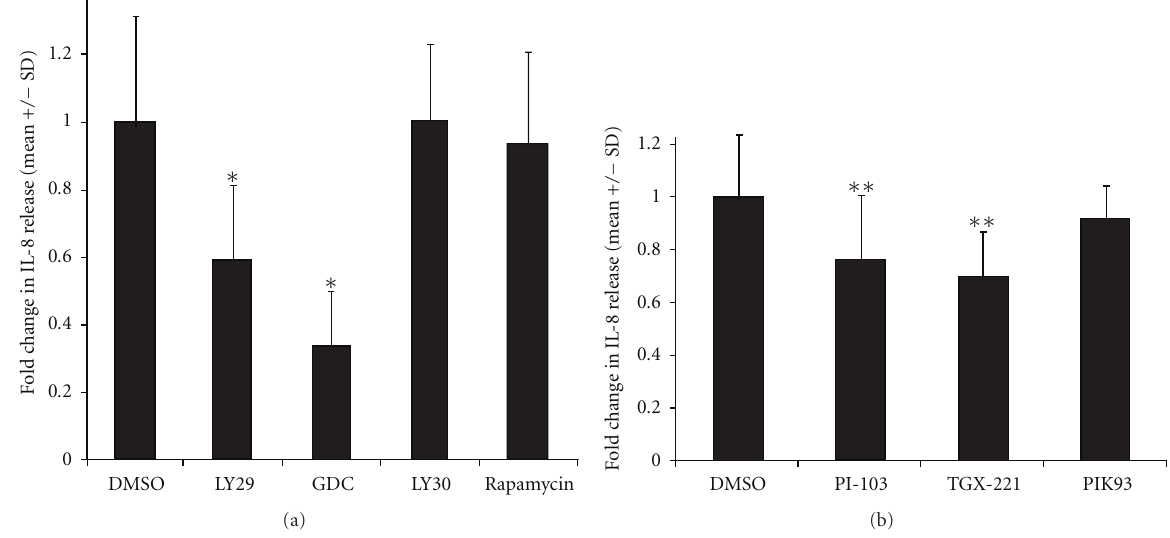
Figure 4: PI3K inhibition reduces IL-8 production after flagellin stimulation in Caco-2 cells. Caco-2 cells seeded as described in Methods were treated with the inhibitors shown (all at 10 μ M, except for 30 μ M LY29 and LY30) or an equivalent dose of DMSO vehicle in complete culture media. Thirty minutes later, flagellin was added to a final concentration of 100 ng/ml, and cell supernatants harvested 3 hours later. IL-8 was measured by ELISA, and the values in each experiment were normalized to the flagellin + DMSO wells. (a) E ff ects of broadly reactive PI3K inhibitors. (b) E ff ects of isoform-specific inhibitors. ∗ P < . 001 versus DMSO; ∗∗ P < . 01 versus DMSO ( t -test). Results compiled from N of at least 10 for each